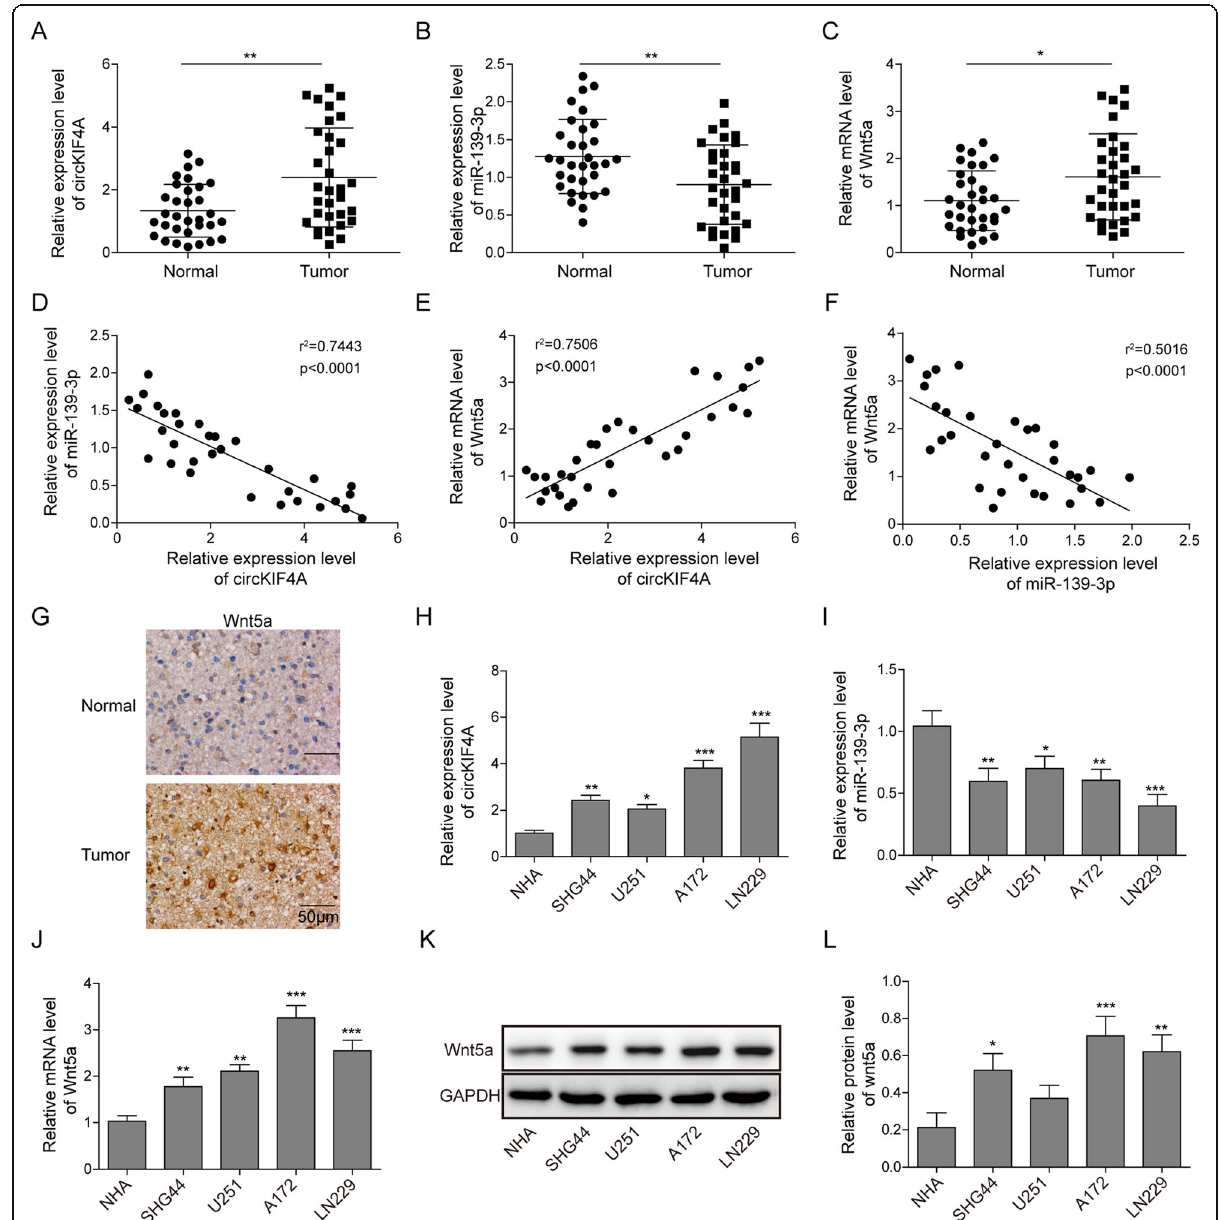
Fig. 1 Expression of circKIF4A, miR-139-3p and Wnt5a in several glioma cell lines and tissues. The expression level of circKIF4A ( a ) miR-139-3p ( b ) and Wnt5a ( c ) was detected by qRT-PCR in glioma tissues and adjacent normal tissues. The correlation between circKIF4A and miR-139-3p ( d ), circKIF4A and Wnt5a ( e ), miR-139-3p and Wnt5a ( f ) expression were determined by Spearman correlation analysis. g The protein level of Wnt5a was detected by immunohistochemical in glioma tissues and adjacent normal tissues. The expression level of circKIF4A ( h ) miR-139-3p ( i ) and Wnt5a ( j ) was detected by qRT-PCR in four glioma cell lines including A172, SHG44, U251 and LN229, as compared with NHA cell line. k The protein level of Wnt5a was detected by Western blotting in glioma cell lines and NHA cell line. l The quantification of Wnt5a relative protein level as a ratio to that of GAPDH (internal control). * p < 0.05, ** p < 0.01, *** p <